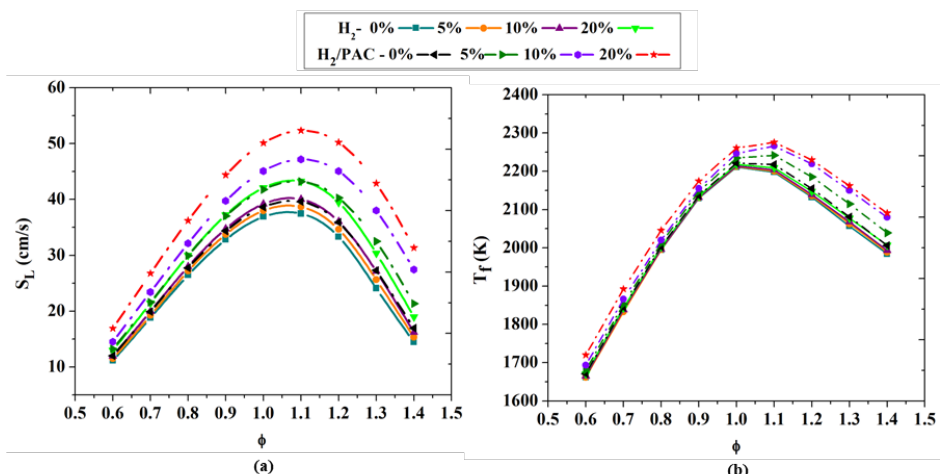
Figure 6. Comparison of ( a ) flame speed and ( b ) flame temperature at various equivalence ratios using different H 2 contents with or without NSPD.